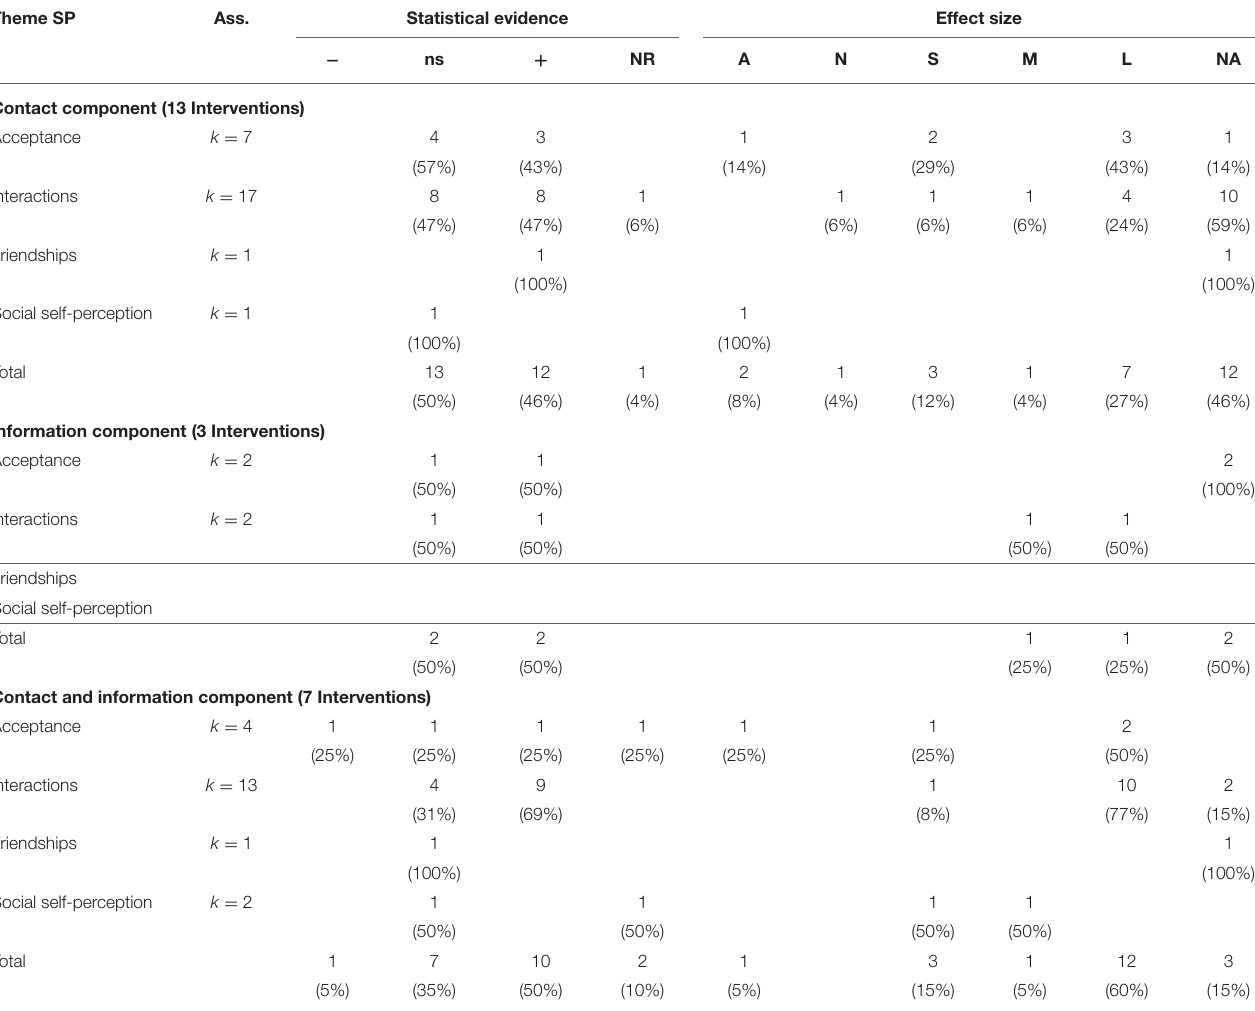
TABLE 8A | Number of associations by intervention component and by social participation theme from group design studies. Theme